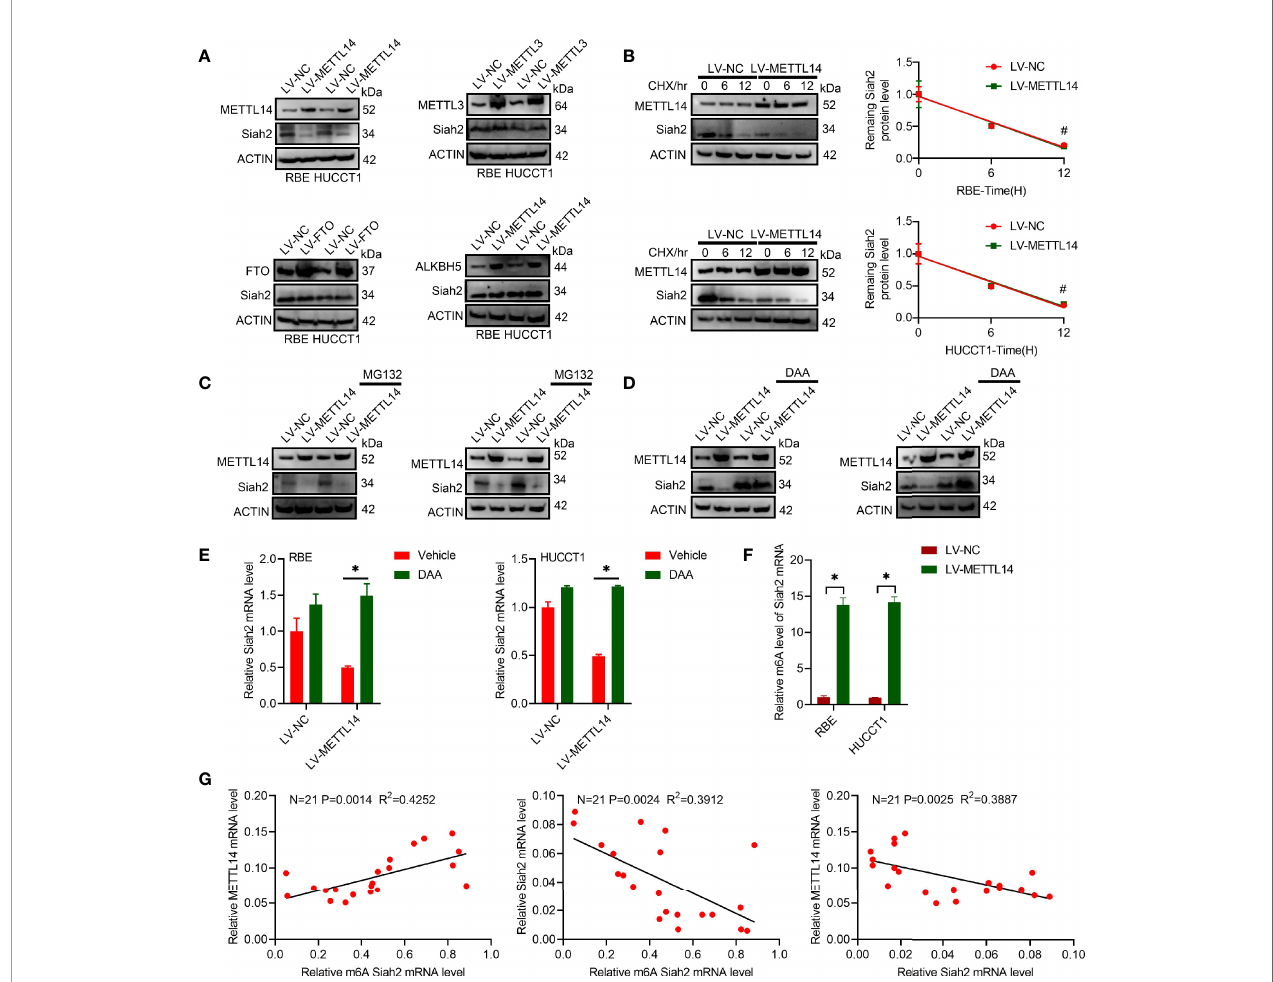
FIGURE 1 | Siah2 is a direct target of METTL14-induced m6A modi fi cation in CCA. (A) , Western blot analysis for Siah2 expression in CCA cell lines with stable METTL14, METTL3, ALKBH5, or overexpressed FTO. (B) , The rate of Siah2 protein degradation was checked by Western blotting in CCA cells with METTL14 knocked down upon CHX (protein synthesis inhibitor) treatment. (C) . Western blot analysis for Siah2 expression in CCA cells with METTL14 knocked down upon MG132 treatment. (D, E) , Western blot and RT-PCR analysis for Siah2 expression in CCA cells with LV-NC/-METTL14 upon DDA 0 – 25 mmol/L treatment for 24 h. (F) , m6A fold enrichment of Siah2 total mRNA detected by MeRIP quantitative RT-PCR of fragmented mRNA with indicated primers. (G) , Correlation between METTL14 MRNA level, M6A level of Siah2, and Siah2 MRNA level in CCA tissues. Mean±SEM of three independent experiments. *P<0.05; # P >